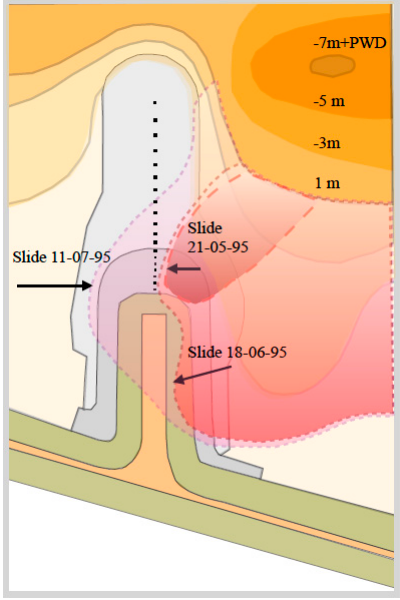
Figure 12. Sketch of groyne G-2 with a local scour hole and with the damaged areas by three flow slides [23] (sketch prepared by the author). Legend: dark yellow = river bed with contour lines local scour hole, transparent red = damage area by a flow slide, grey = falling apron, black dot = pile of permeable groyne, green = slope embankment, sand color = top of embankment.